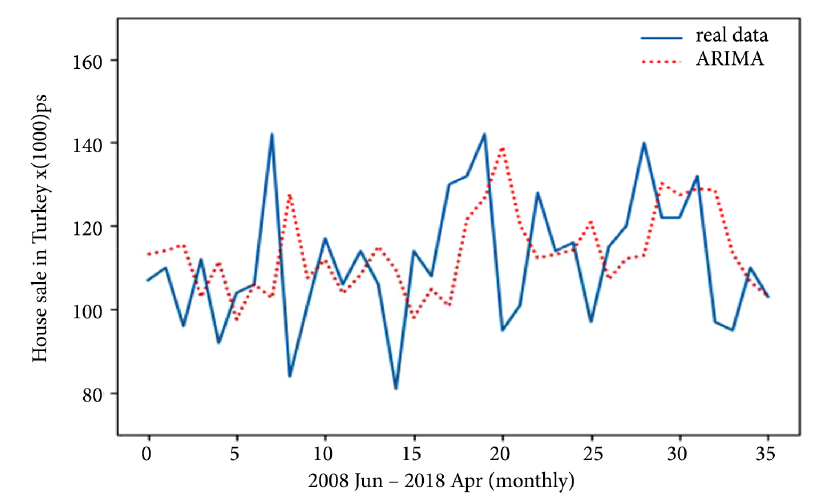
Figure 5. ARIMA (0,1,2) model and ground